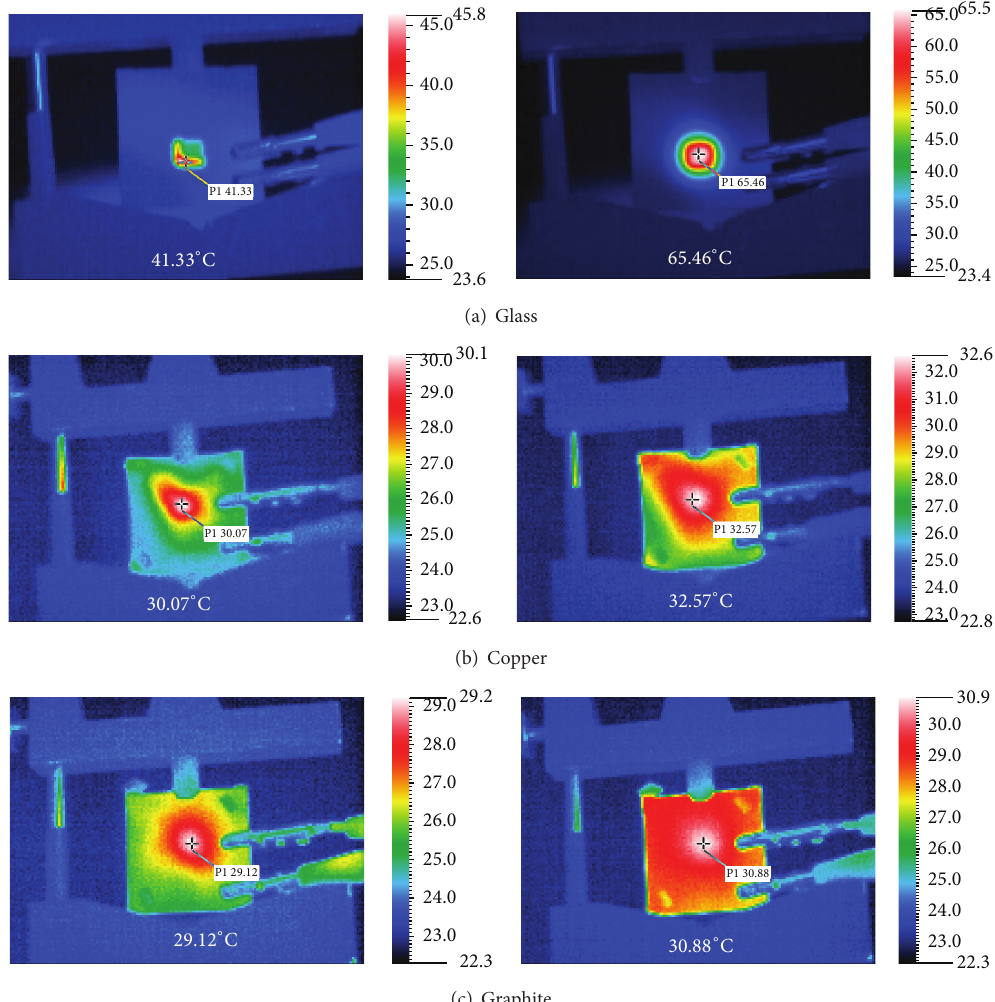
Figure4:Temperaturewhen(a)theglass(b)copperor(c)graphitesubstratedeviceisoperated.Liftisoperatedfor5seconds;rightisoperated for 25